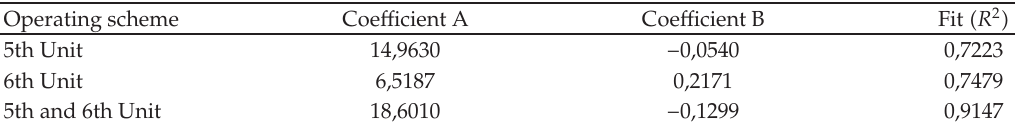
Table 1: Coe ffi cients A and B for the inlet and outlet temperature power plan formulation for the three operating